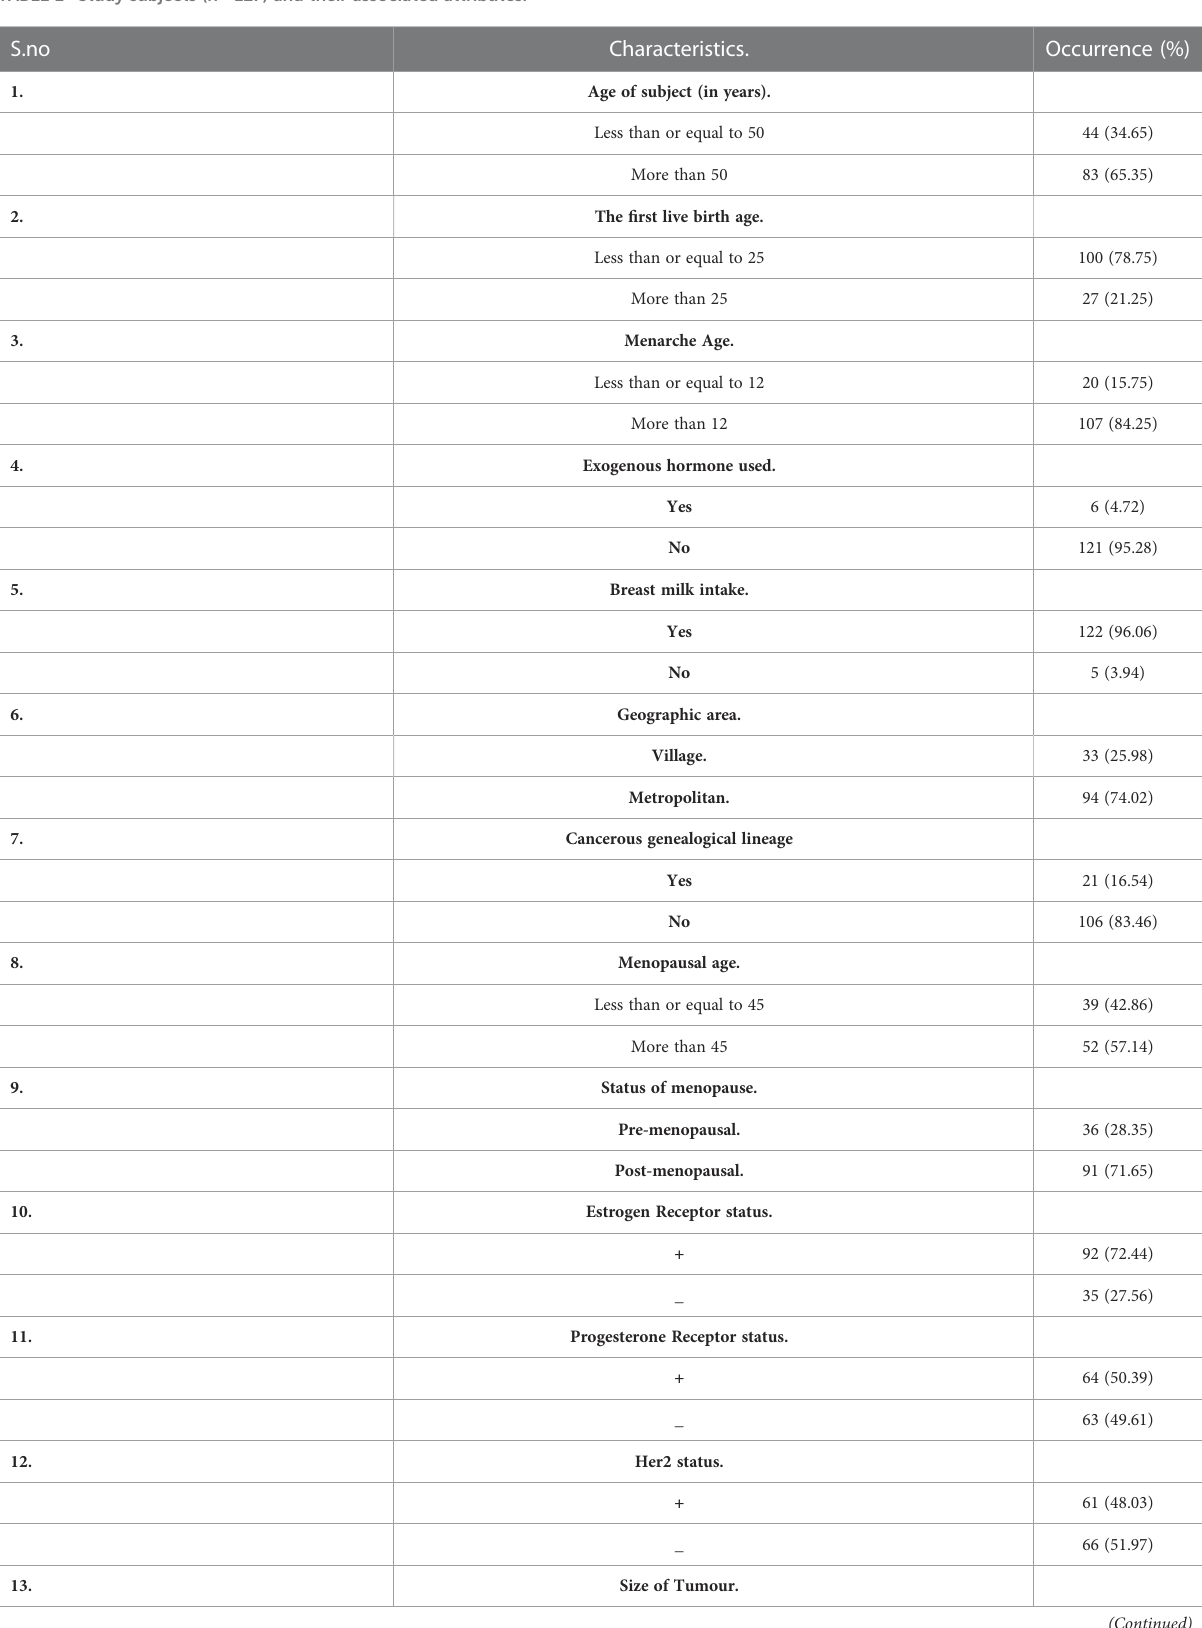
TABLE 1 Study subjects (n =127) and their associated